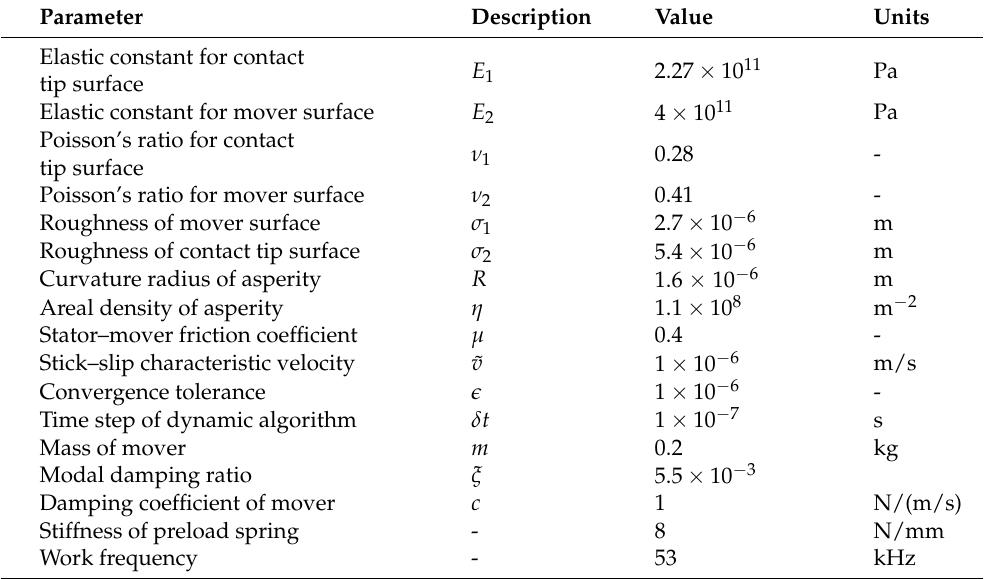
Table 2. Summary of model